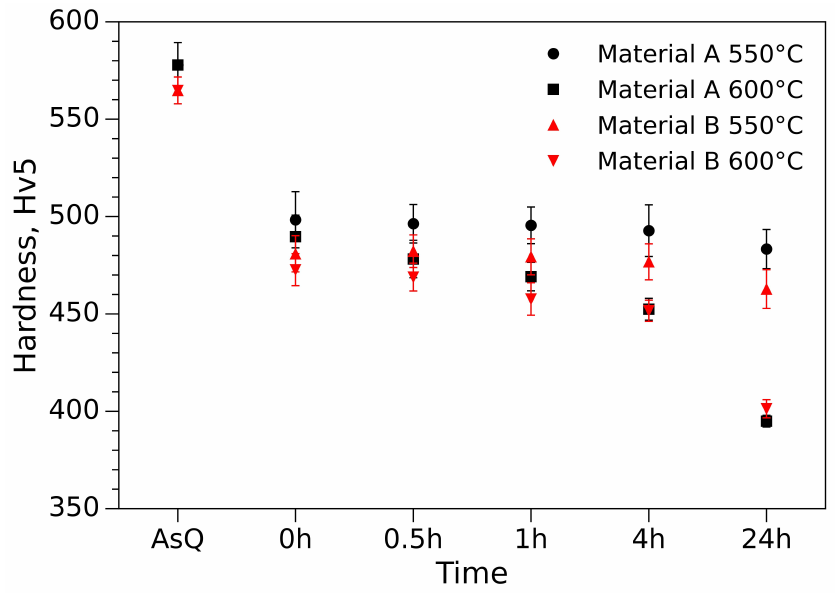
Figure 2. Driving simulator—smartwatch. Figure 3. Microhardness as a function of tempering